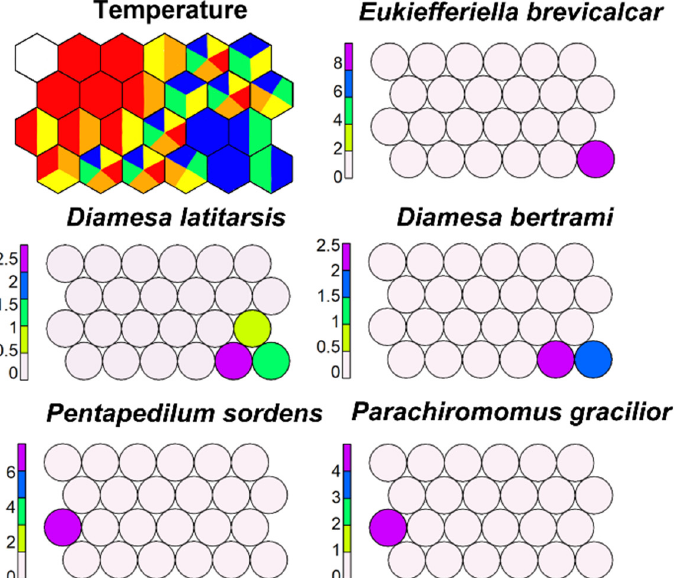
external variable. Blue, <7.5 ◦ C; green, 7.5–8.5 ◦ C; yellow, 8.5–12 ◦ C; orange, 12–14 ◦ C; red, >14 ◦ C. Figure 15. Supervised map of sites and five morphotaxa clustered using temperature (in °C) as ex- ternal variable. Blue, <7.5 °C; green, 7.5–8.5 °C; yellow, 8.5–12 °C; orange, 12–14 °C; red, >14 °C.